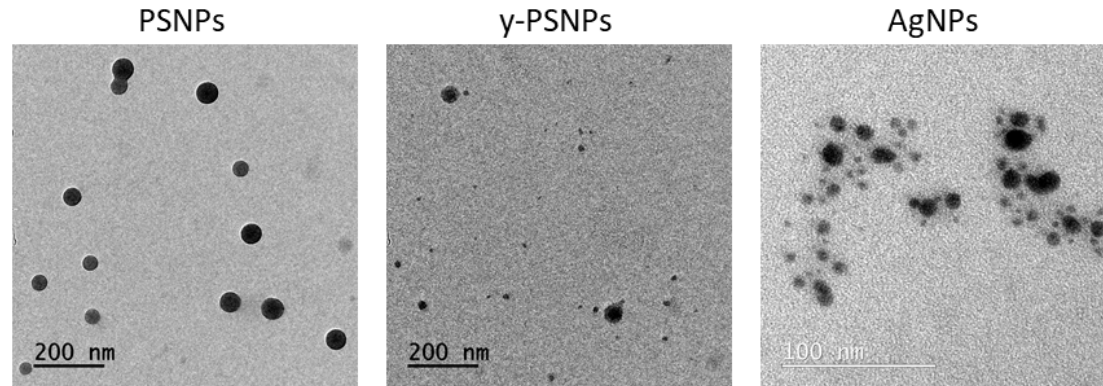
Figure 1. Representative TEM images of PS nanomaterials (PSNPs and y-PSNPs) and AgNPs. Dilutions of 100 µ g/mL in distilled water of each material were used for the visualization. Table 1. PS nanomaterials and AgNPs characterization by TEM (median size) and Zetasizer Nano ZS (mean ±